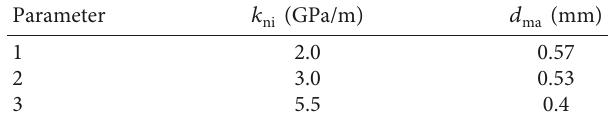
Figure 8: Reflection coefficient d ni and ma [19].